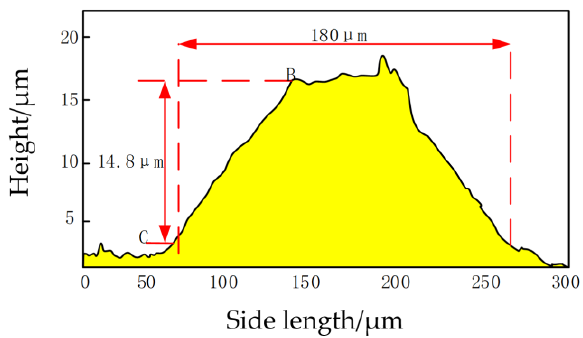
Figure 14. Two-dimensional tabular morphology along the A-A section.